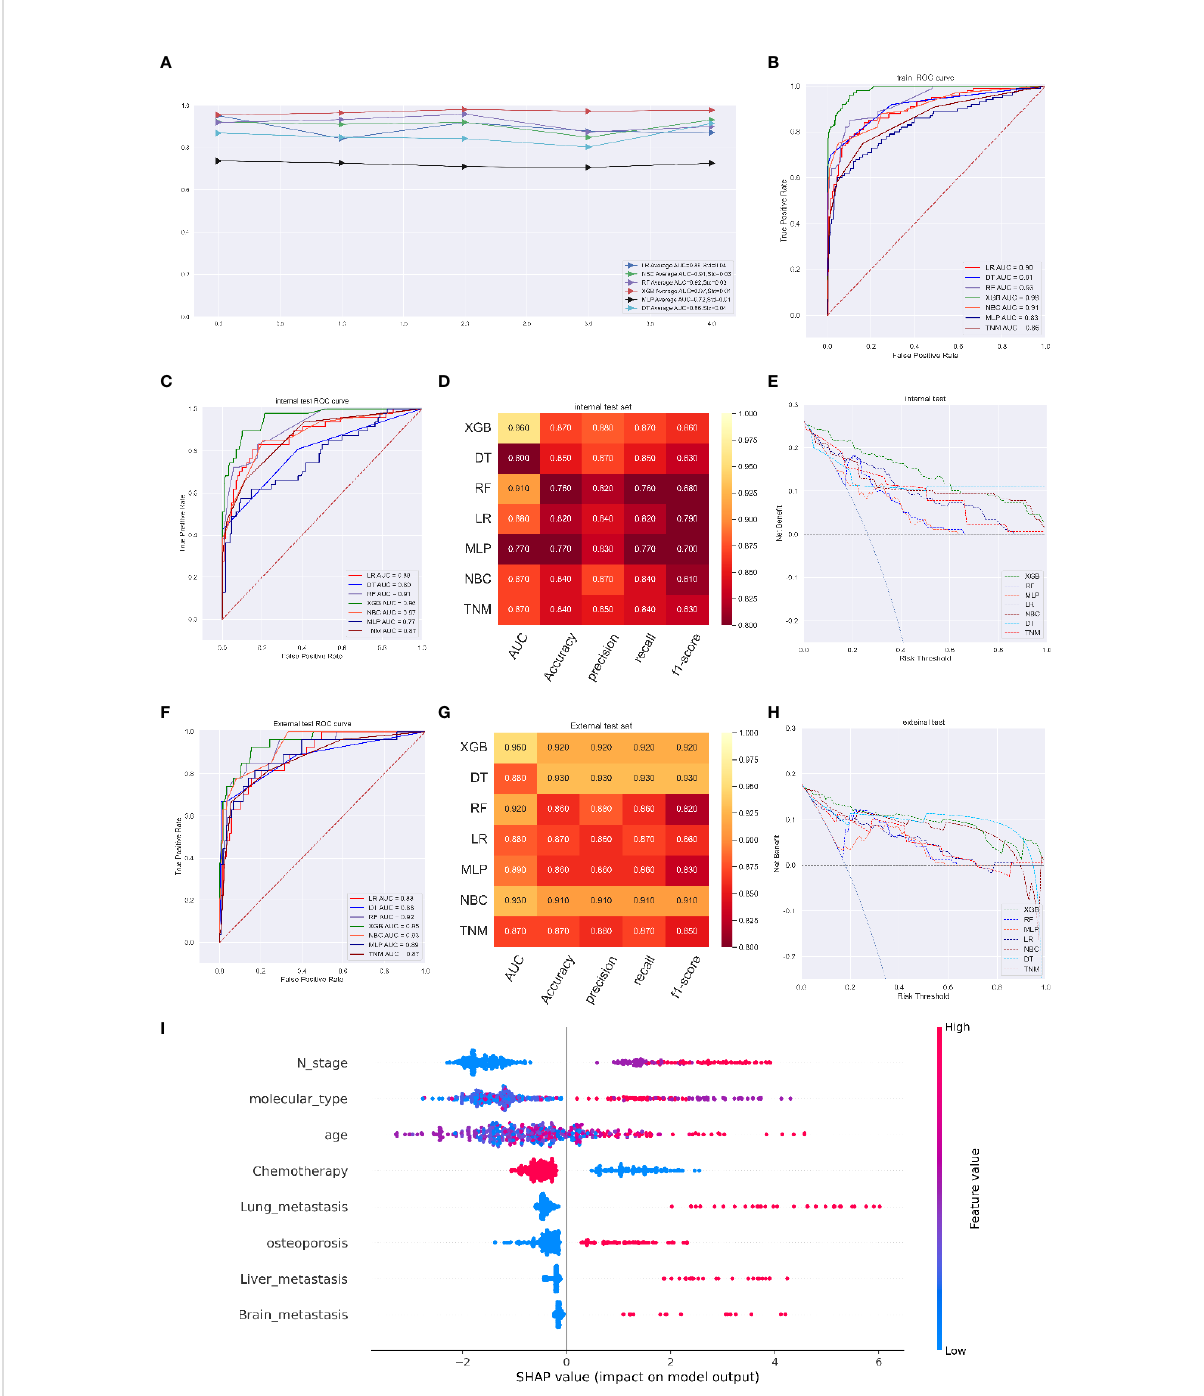
FIGURE 4 (A) Five-fold cross-validation results of different machine models in training set. (B) The ROC curve of different machine learning models, TNM stage model in training test set. (C) The ROC curve of different machine learning models and TNM stage model in internal test set. (D) Prediction performance of different models and TNM stage model in internal test set. (E) The DCA curve of different machine learning models and TNM stage model in internal test set. (F) The ROC curve of different machine learning models and TNM stage model in external test set. (G) Prediction performance of different models and TNM stage model in external test set. (H) The DCA curve of different machine learning models and TNM stage model in external test set. (I) Feature importance plot for the XGB osteoporosis prediction model. All the features are shown in this fi gure. The blue and red points in each row represent nodules having low to high values of the speci fi c feature, while the x -axis shows the SHAP value, indicating the impact on the model. (survival predicting model for 8